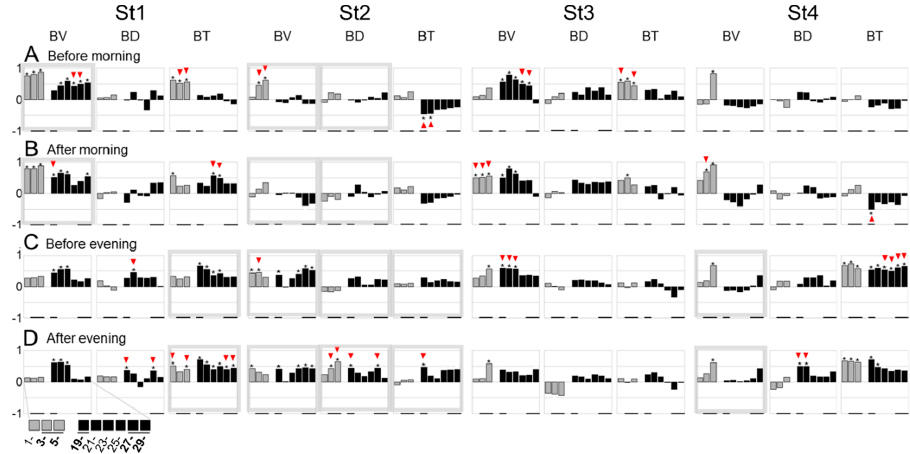
Figure 5. Screening of feeding dependence at night in two-hour increments on the basis of B- variables. Pearson correlation coefficients between the mean values 30 min before/after morning/evening feeding and in 2-h increments at night for each variable. * p < 0.05. Red triangle indicates differences before and after feeding in either ‘significant’ or ‘not significant’ results. A pair of graphs surrounded by a gray square denote significant differences before and after feeding. Black underbars indicate the focal night hours as determined by this screening.